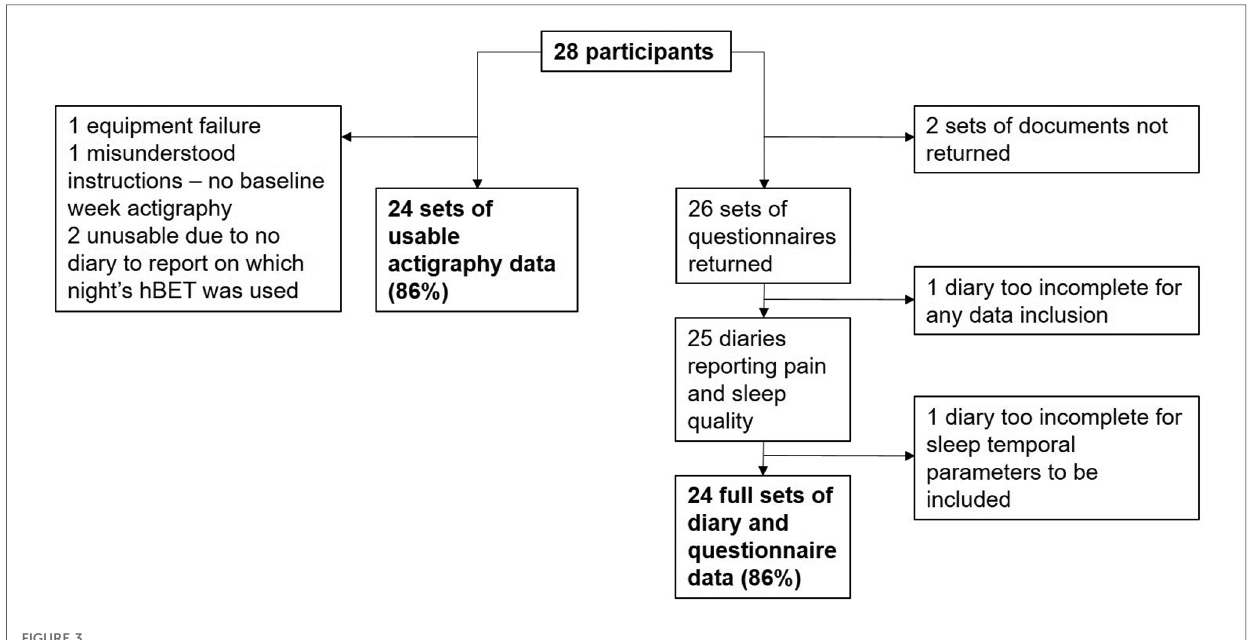
FIGURE 3 Data completeness and sources of attrition.